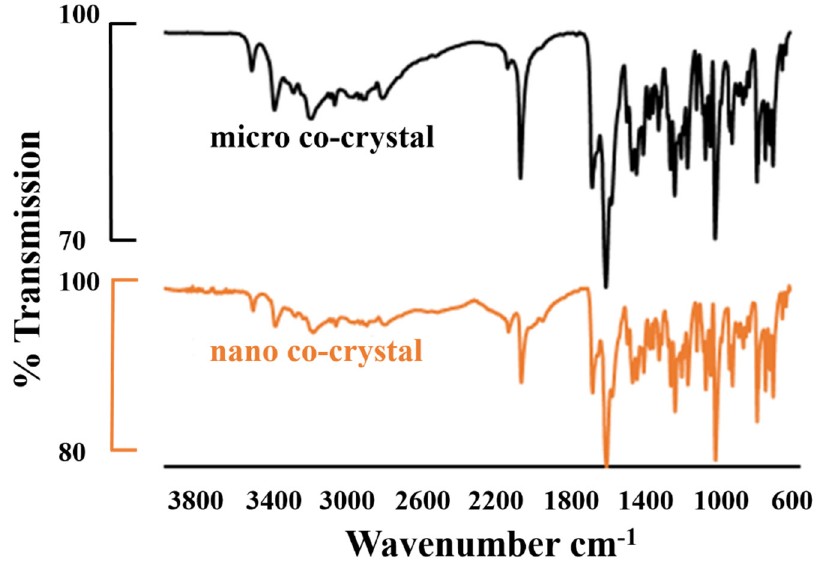
Figure 1. FTIR absorption spectra of the micro (black) and the nano co-crystal (orange).